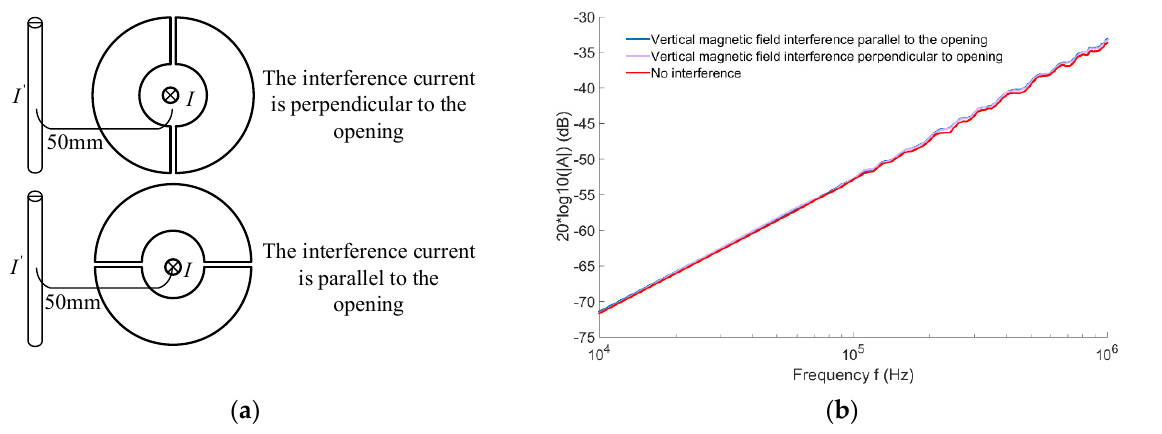
Figure 16. Vertical magnetic field interference. ( a ) Placement method; ( b )The amplitude-frequency response curve of Rogowski coil in the presence of external vertical interference.